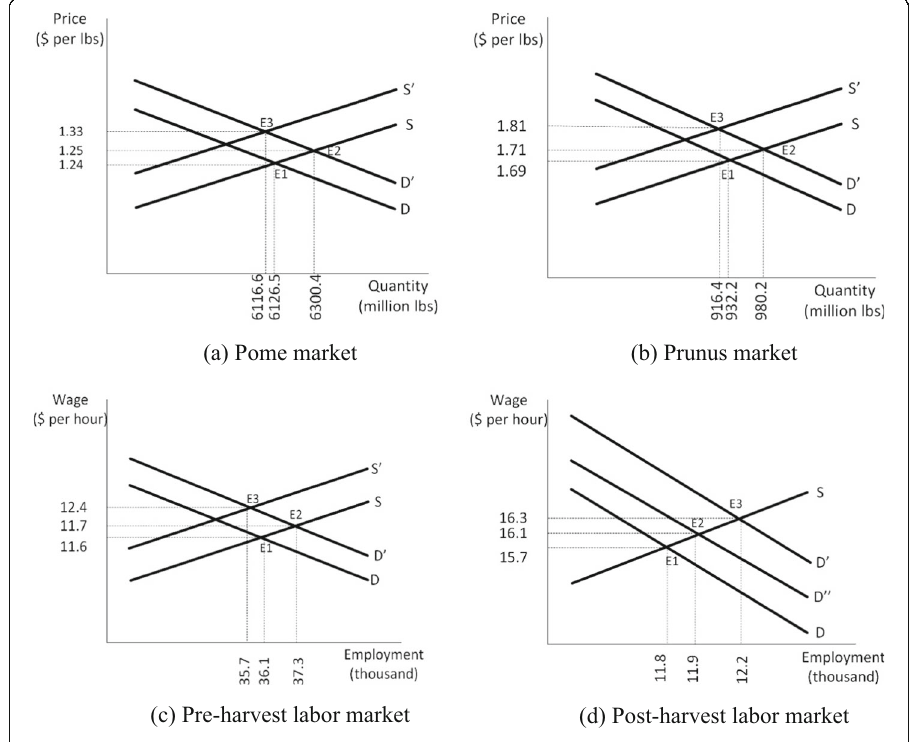
Fig. 1 Illustrative example of pre-shock and post-shock competetive equilibrium for a pome, b prunus, c pre-harvest labor, and d post-harvest labor